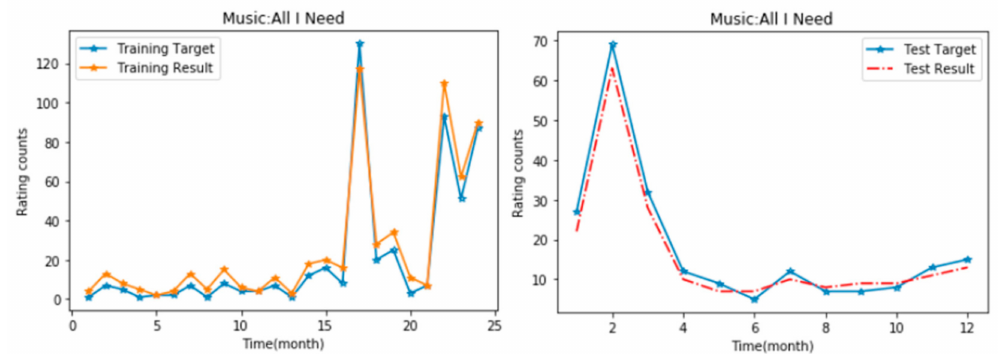
Figure 7. Time series prediction of popularity of LFM-1k data set: left: training results; right: test results.